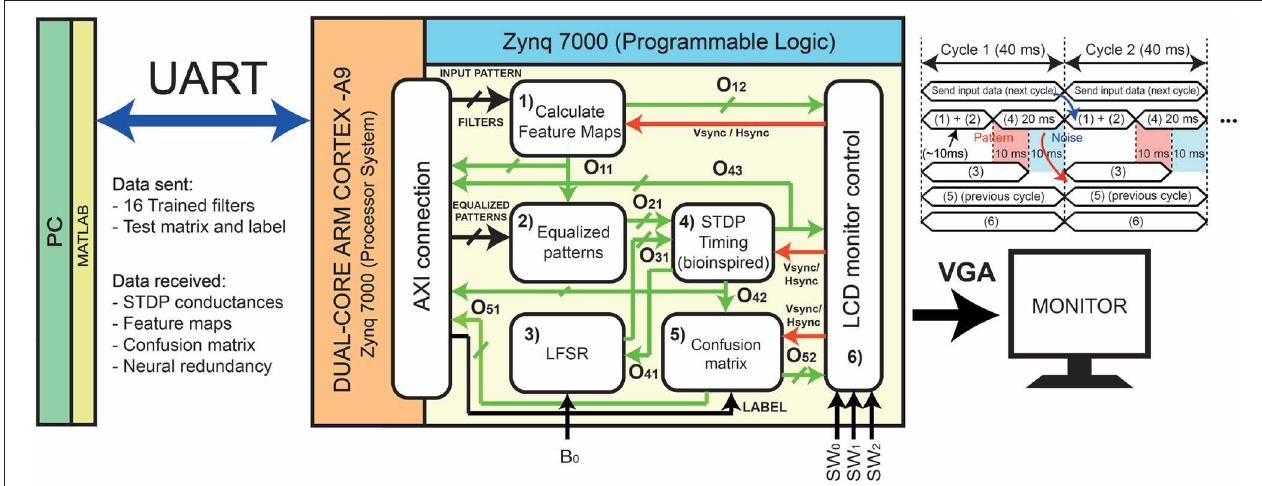
FIGURE 7 | Detailed schematic implementation of the system in the Xilinx Zedboard Dual-Core ARM Cortex (SoC). The filters are transmitted using the UART protocol at a baud rate of 230400 bps, while the operations for classification have been determined in the Programmable Logic part. The external user can decide which classes are trained and which not, and can select the channels of the monitor for observing the intermediate or the final results. Note that the management of the data transfer is pipelined with the convolution plus STDP